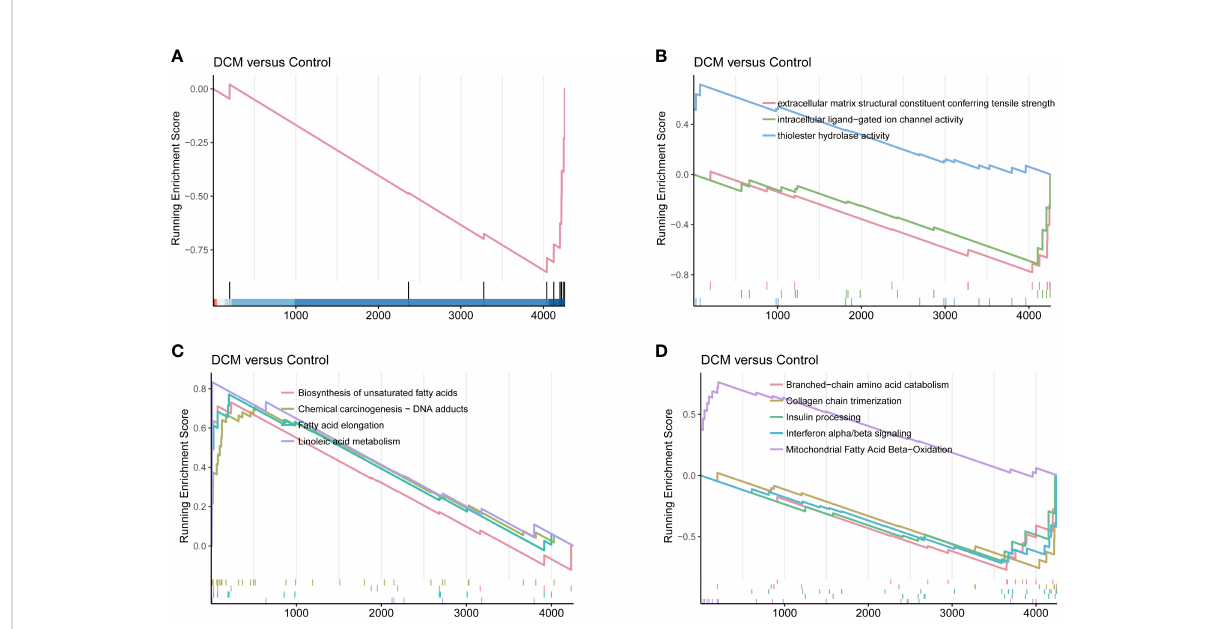
FIGURE 5 DCM-related gene set enrichment analysis. (A) Cell component. (B) Molecular function. (C) KEGG pathway. (D)